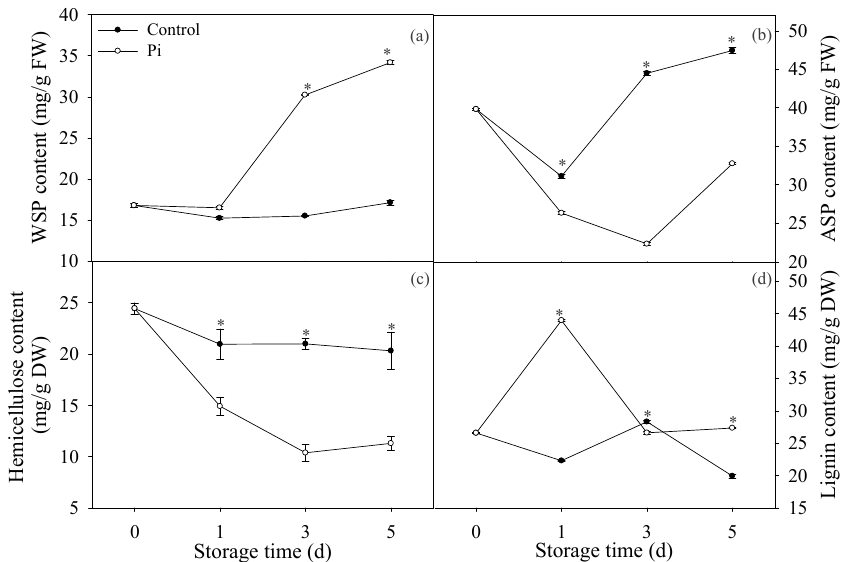
Figure 1. Effects of P. italicum infection on water-soluble pectin (WSP) ( a ), acid-soluble pectin (ASP) ( b ), hemicellulose ( c ) and lignin ( d ) of mandarin peel during storage at 25 o C. Each data point represents a mean of three replicate assays ± standard error. Asterisks at the same storage time represented the significant differences ( P < 0.05). FW: fresh weight; DW: dry weight.